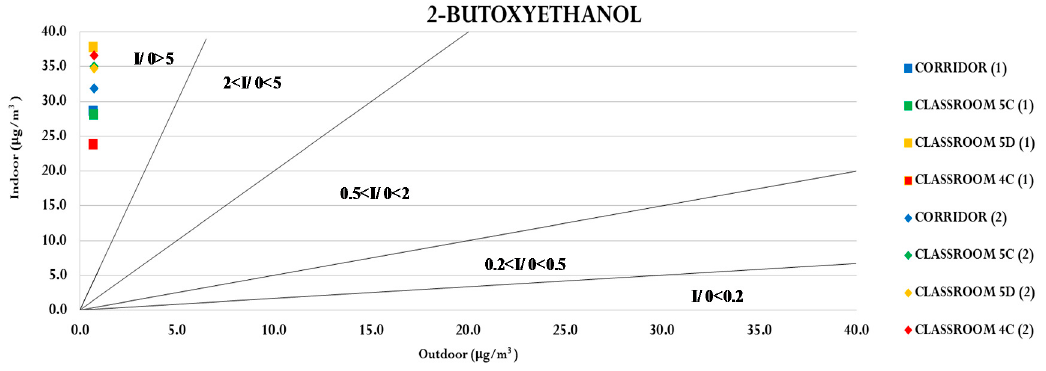
Figure 6. 2-Butoxyethanol indoor concentrations against outdoor concentrations in all monitored sites during the first (1) and the second (2) monitoring periods.